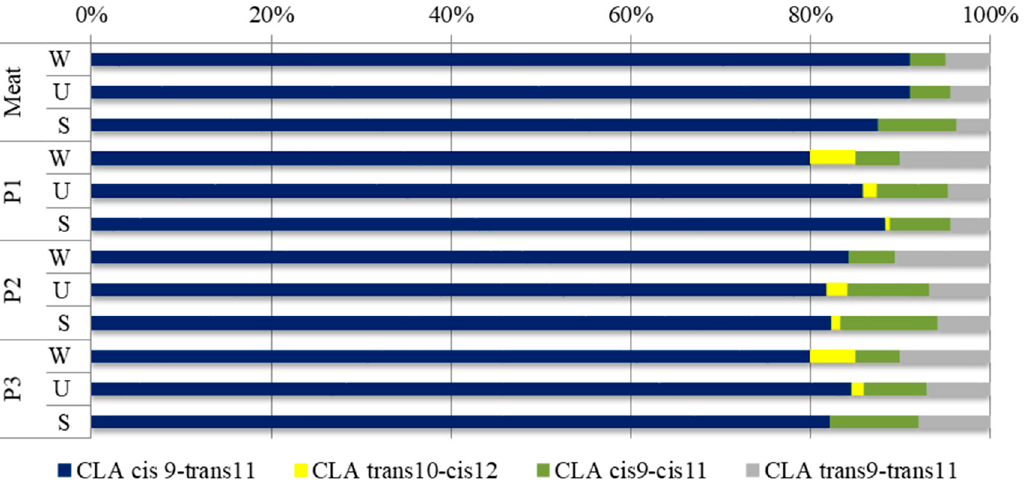
Figure 3. The contribution of individual CLA isomers to the total quantity of conjugated linoleic acid. W, U, S — lamb breeds: W — Wrzosówka, U — Uhruska, S — Ś winiarka; P1–P3 types of treatment: P1 — treatment with sea salt and sodium nitrate, P2 — treatment with sea salt, and P3 — treatment with sea